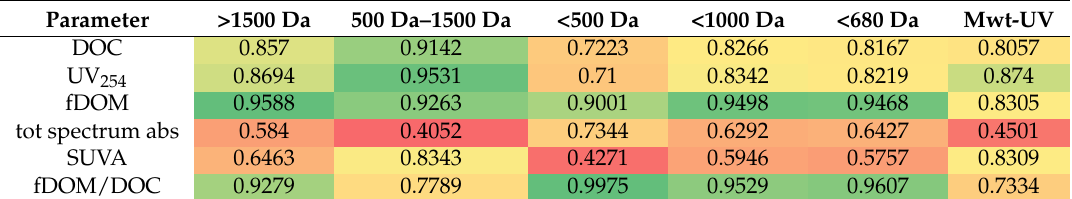
Figure 10. MW distribution by HPSEC—Humics’ fluorescence; combined chromatographs. Table 2. Coefficients of determination between proposed indices and molecular weight (MW)